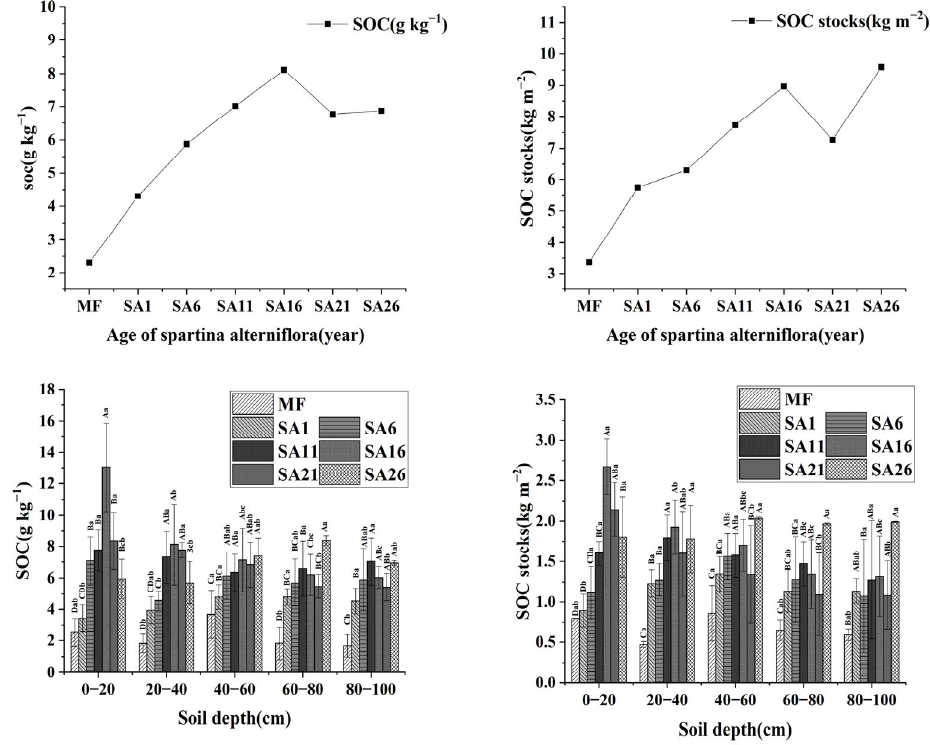
Figure 3. Distribution characteristics of soil SOC content and storage at different stages of invasion. Different letters indicate significant differences between different years of invasion or soil depths. ( p < 0.05).